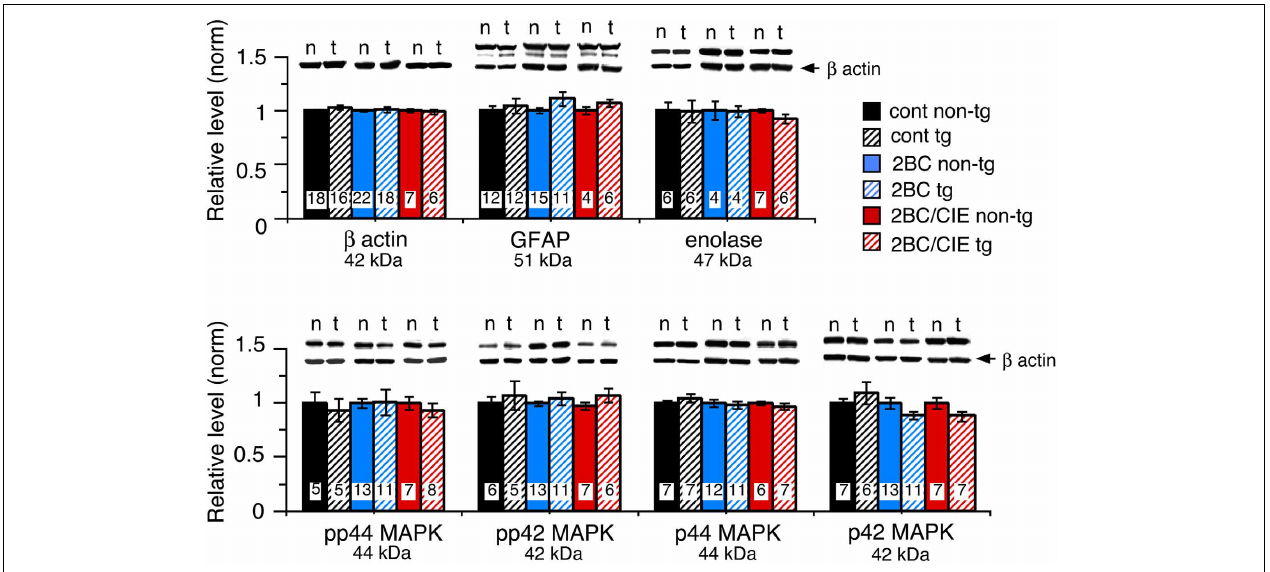
FIGURE 2 | Levels of housekeeping proteins in CCL2-tg and non-tg hippocampus determined by Western blot. Values are mean ± SEM. Numbers in bars are the number of animals studied. Representative Western